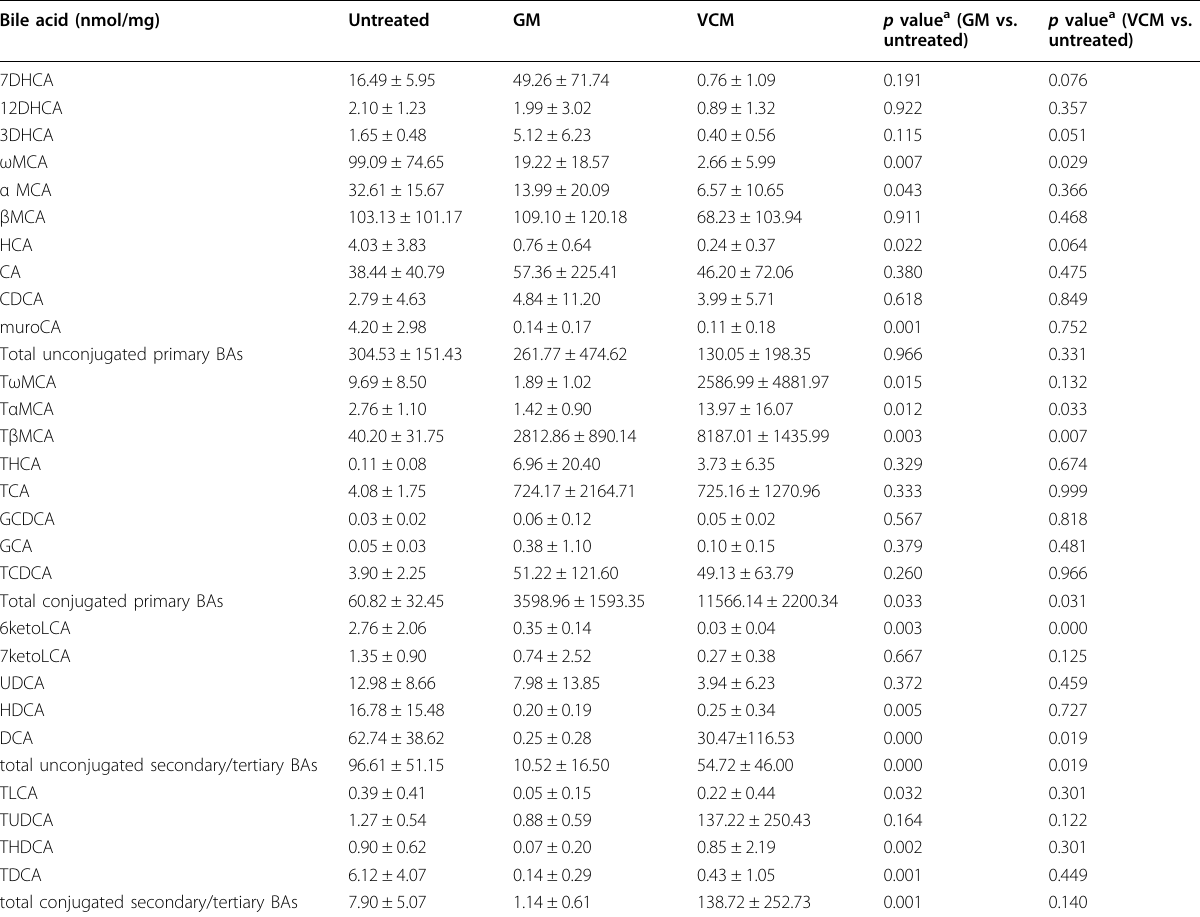
Table 3 Bile acid pro fi les in the serum of mice (nmol/L) Bile acid